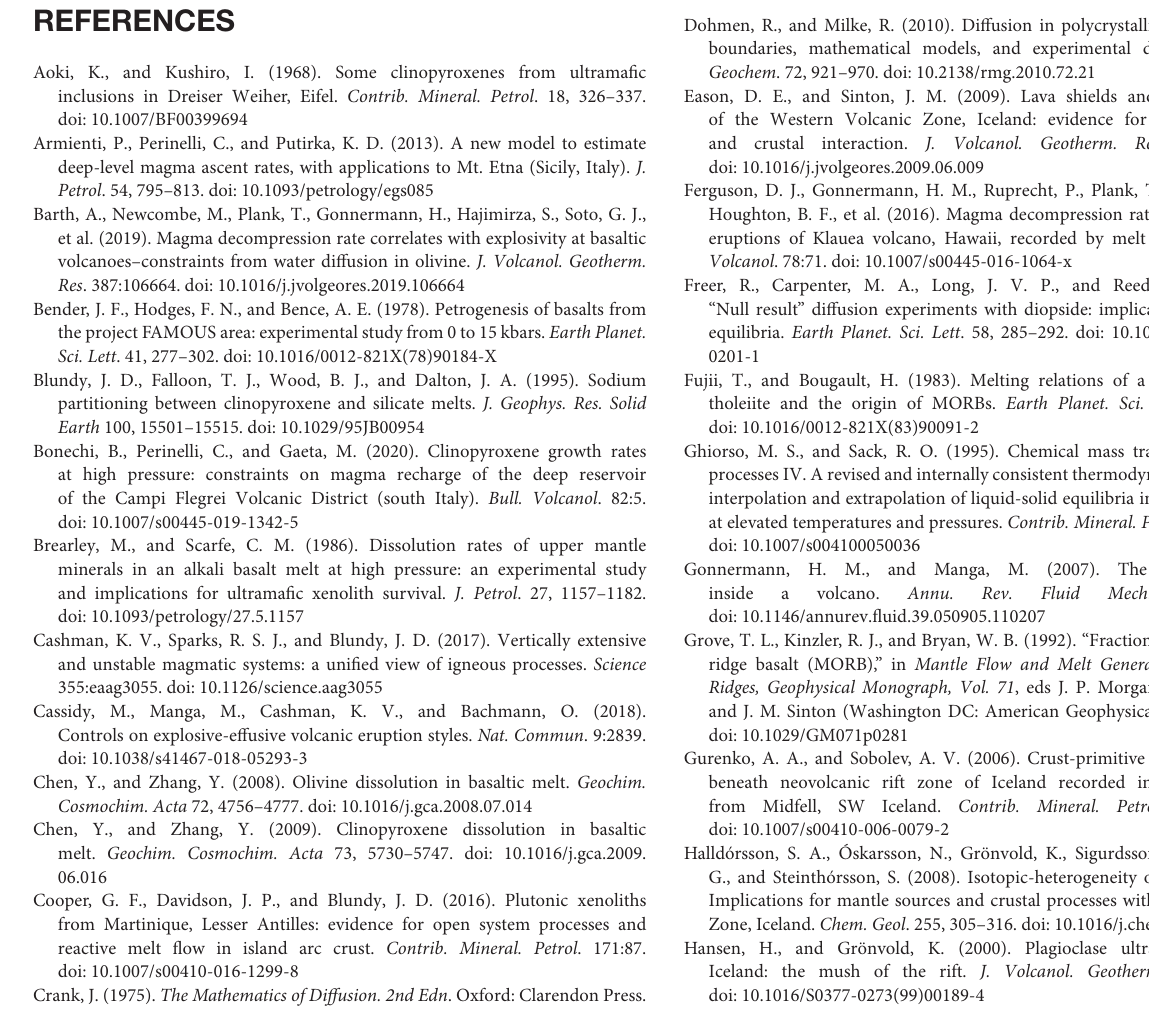
Supplementary Figure 1 | JM21 4 µ m QEMSCAN Al Map. Supplementary Figure 2 | JM21 4 µ m QEMSCAN Phase Map. Supplementary Figure 3 | JM24 4 µ m QEMSCAN Al Map. Supplementary Figure 4 | JM24 4 µ m QEMSCAN Phase Map. Supplementary Figure 5 | JM27 4 µ m QEMSCAN Al Map. Supplementary Figure 6 | JM27 4 µ m QEMSCAN Phase Map. Supplementary Figure 7 | QEMSCAN